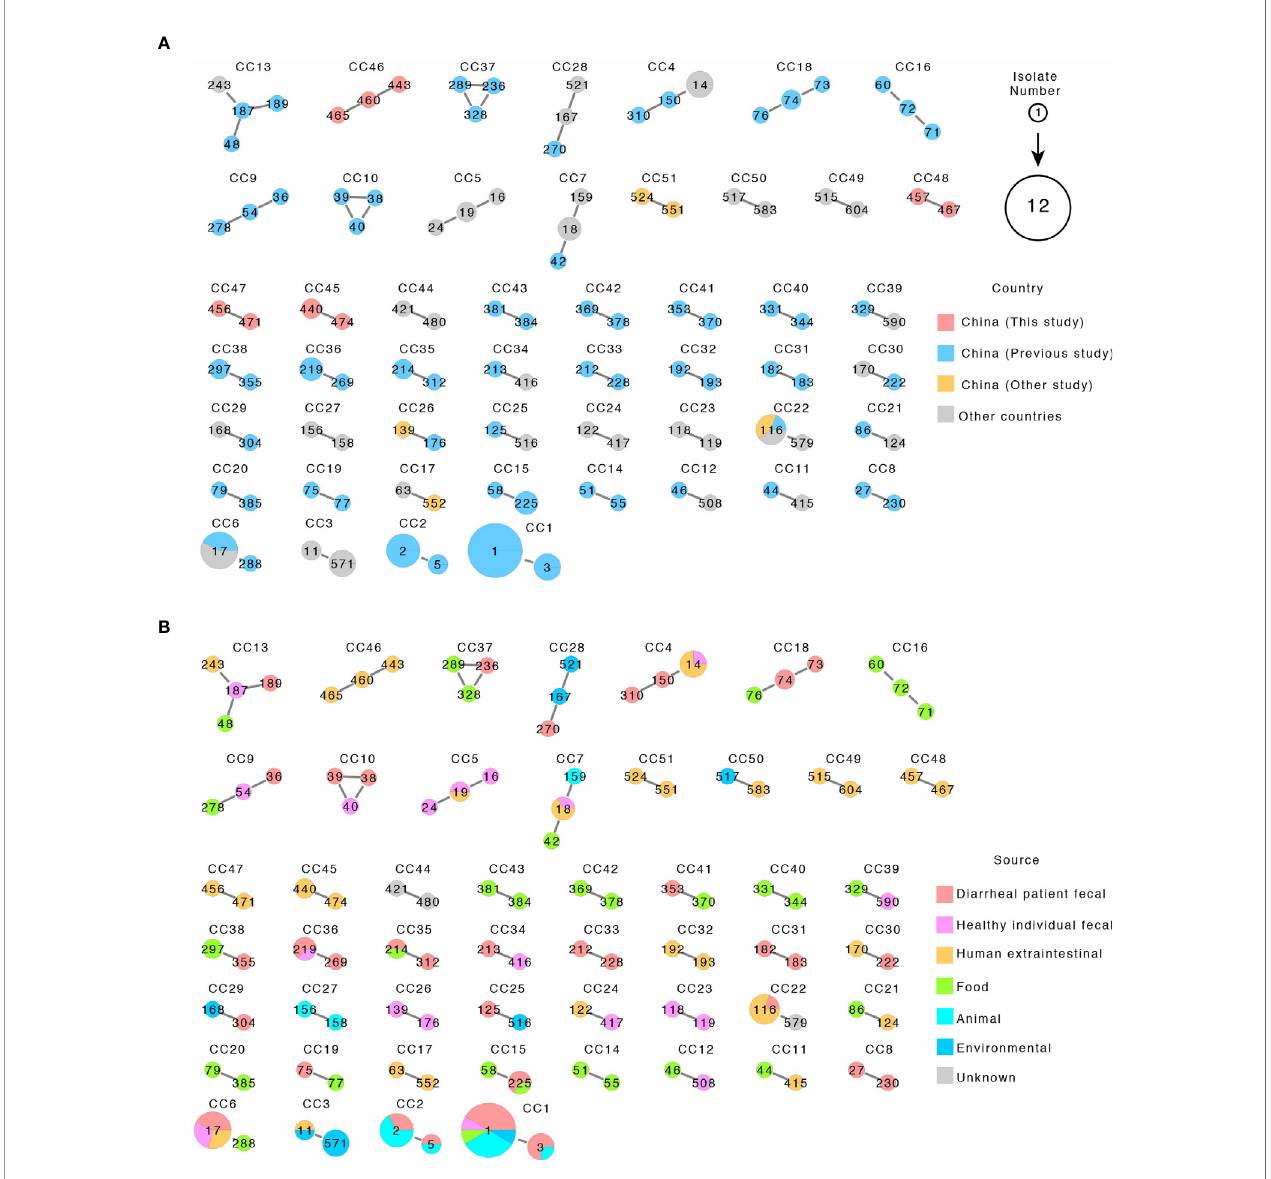
FIGURE 3 | The 51 clonal complexes (CCs) by eBURST of 116 STs from this study and related STs from the public MLST database. (A, B) are the same CCs with A colored by country and B colored by source. Each circle represents an ST, and STs within CC are connected by solid line. ST numbers are marked inside the circle. Circle sizes are proportional to number of isolates. The pie chart within circles represented proportion of isolates from different country or sources as